Question: According to the figure, is the described quantity increasing or decreasing?
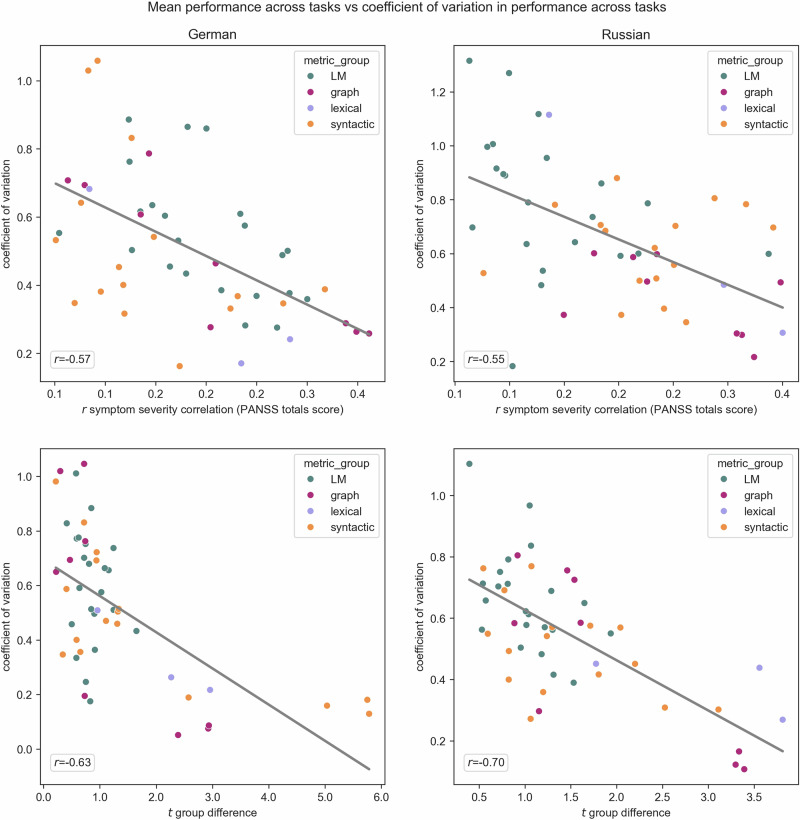
Answer: increasing